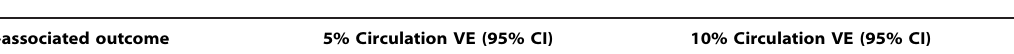
Table 2. Estimates of vaccine effectiveness (VE) for the prevention of influenza A-associated outcomes in community-dwelling Ontario residents aged $ 65 years (95% confidence interval [CI]) during weeks when 5% or 10% of respiratory specimens tested positive for influenza